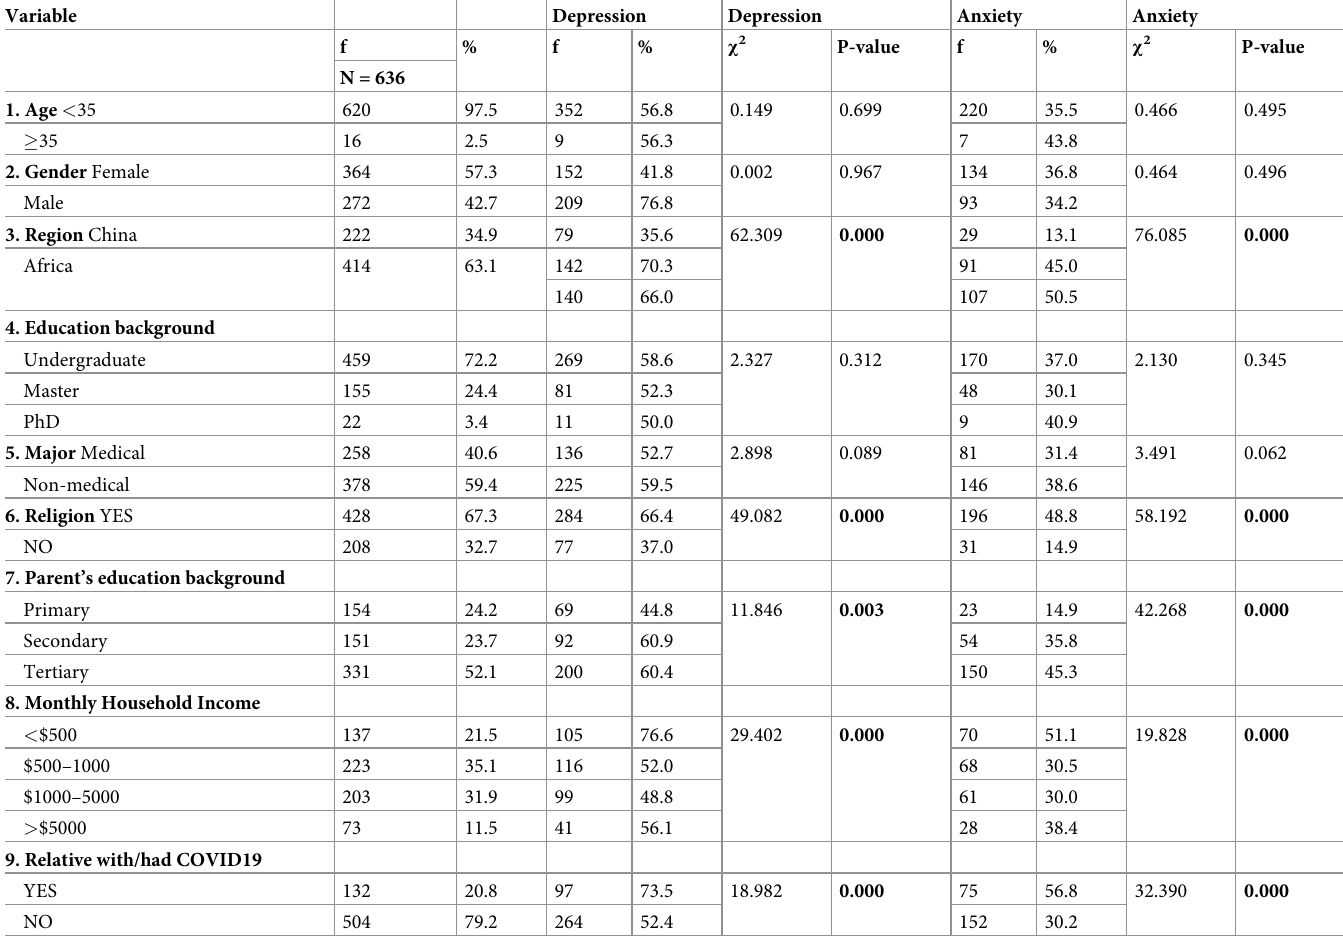
Table 4. Descriptive analysis of association between sociodemographic characteristics and psychological state on all